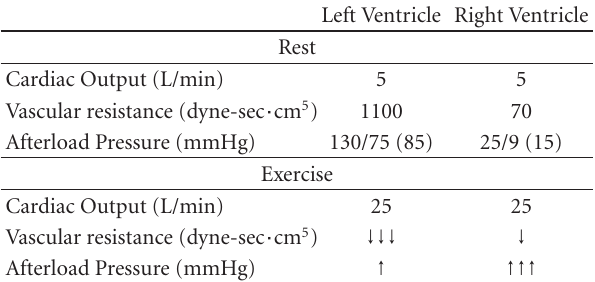
Table 1: Comparison of exercise-induced changes in pulmonary versus systemic vascular resistance and pressure. The pulmonary vasculature has very low resistance at rest but relatively lim- ited capacity for further reduction. Therefore, exercise-induced increases in flow result in greater pressures due to the inability to compensate by reducing resistance. As described by the simplified Poiseuille’s law: Pressure = Flow ×